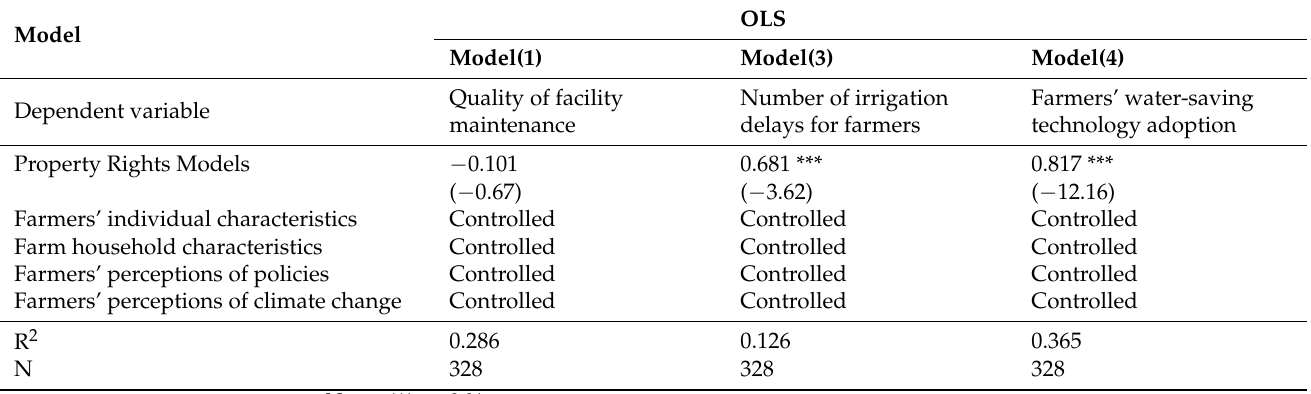
Table 10. Robustness analysis regression results of different property rights models on the quality of facility maintenance and adoption of water-saving